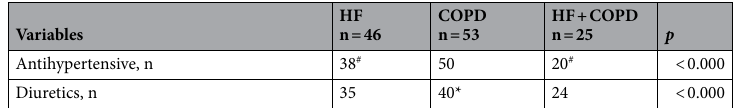
Table 1. Anthropometric and clinical characteristics of studied subjects. Used ANOVA one way for continuous variables and used chi-square test for categorical variables. HF heart failure, COPD chronic obstructive pulmonary disease, M male, F female, BMI body mass index, LV left ventricle, LA left atrium, RVD right ventricle diameter, FEV 1 forced expiratory volume in 1 s, FVC forced vital capacity, RV residual volume, TLC total lung capacity, IC inspiratory capacity, DLCO diffusion capacity carbon monoxide, NYHA New York Heart Association, mMrc modified Medical Research Council scale, DM diabetes mellitus, CI coronary insufficiency, OSA obstructive sleep apnea. Patients that peformed DLCO: 58 (HF:28, COPD:20, HF + COPD:10). *Significant difference (p < 0.05) in relation to the HF group. # Significant difference (p < 0.05) in relation to the COPD